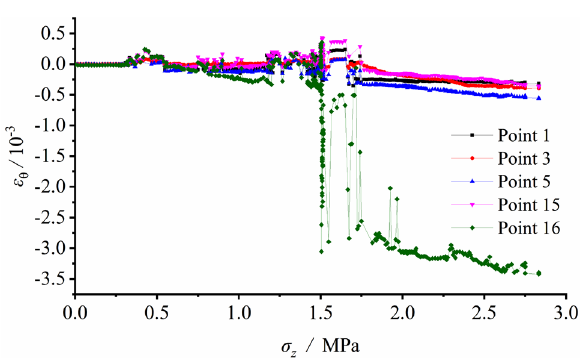
Figure 13. Tangential strain variation vs. vertical load at each measuring spot around the tunnel during unloading with surrounding rock stress of 100% σ zmax .